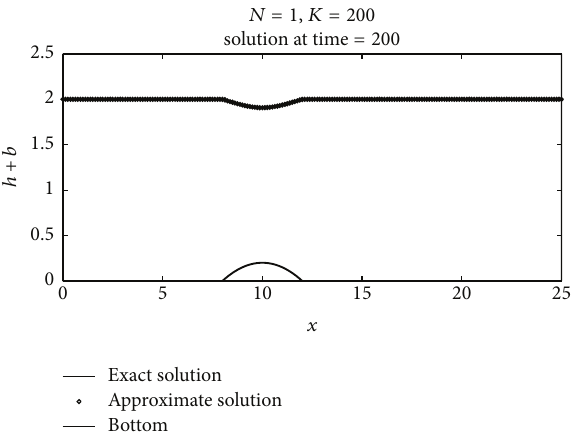
Figure 4: Water depth and bump profiles for subcritical flow.